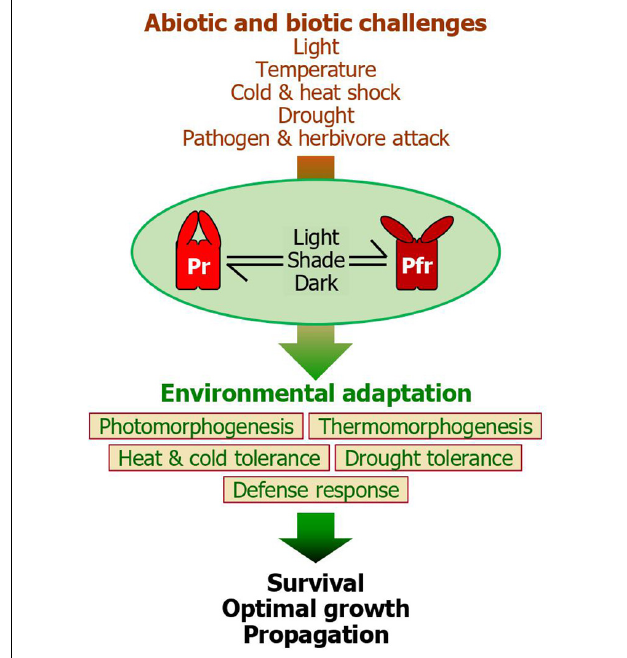
FIGURE 2 | A unified model for the phytochrome function during plant environmental adaptation. While the Pr-Pfr photoconversion plays a central role during photomorphogenic responses, it also integrates a range of light information into plant adaptive behaviors in response to various abiotic